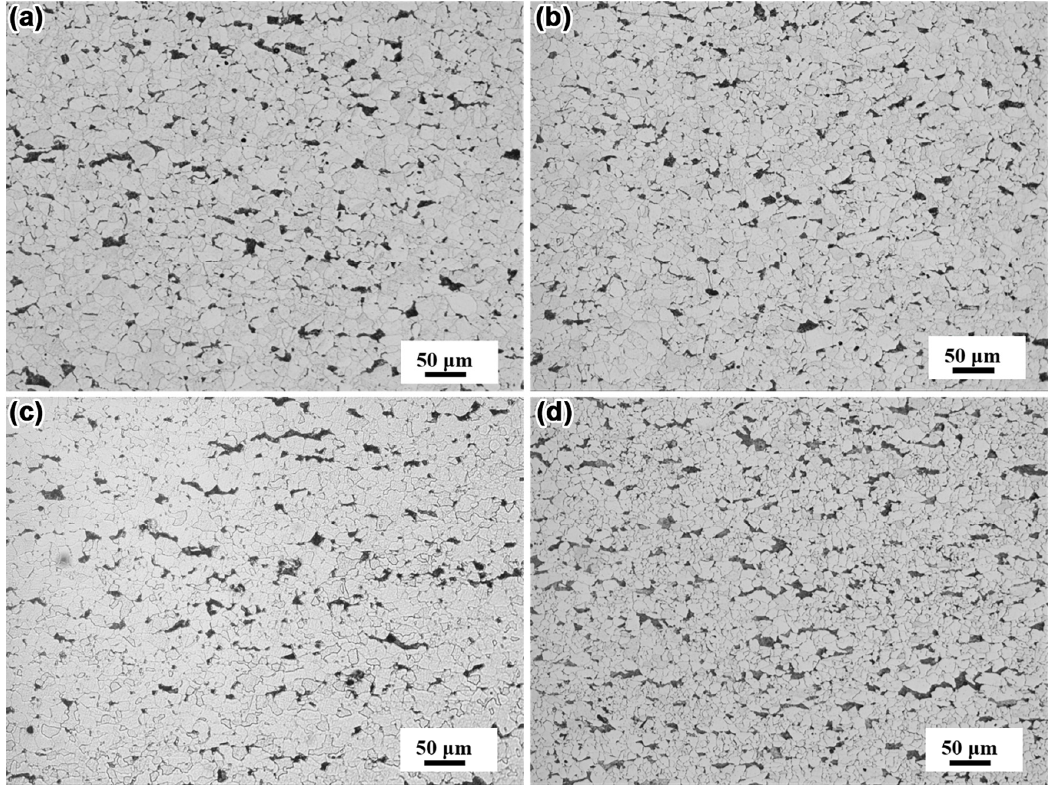
Figure 4. The microstructure of hot rolled steel sheets, ( a ) N1, ( b ) N2, ( c ) N3, and ( d ) N4 steel.